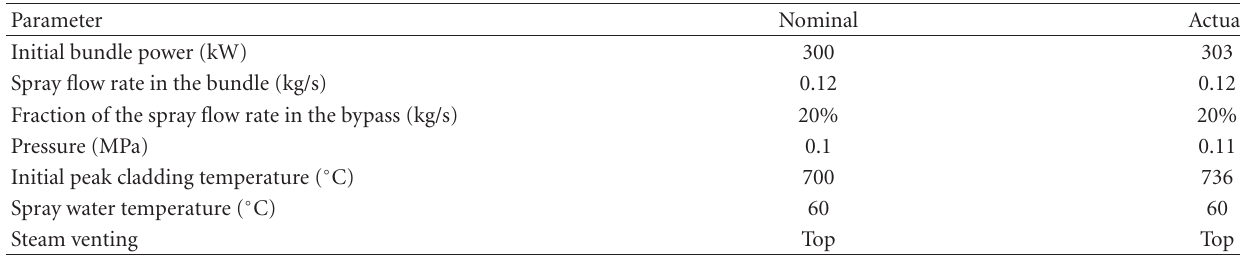
Table 1: Test number 78 initial